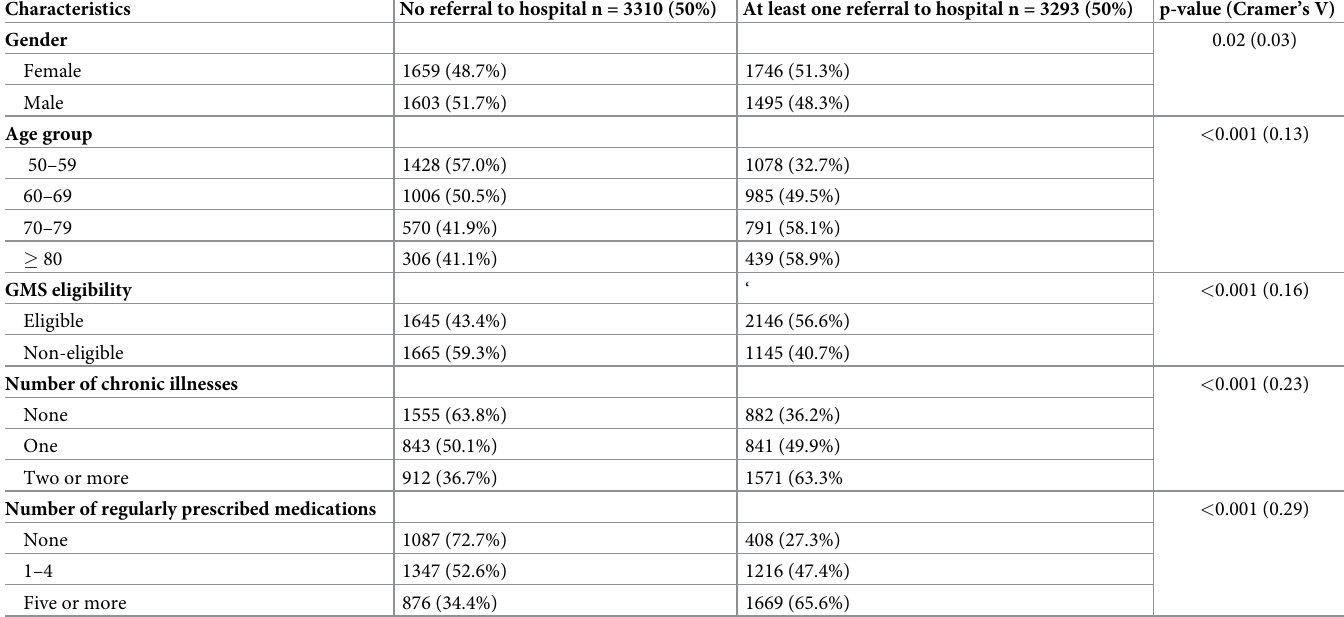
Table 2. Characteristics of patients by referral status. Characteristics